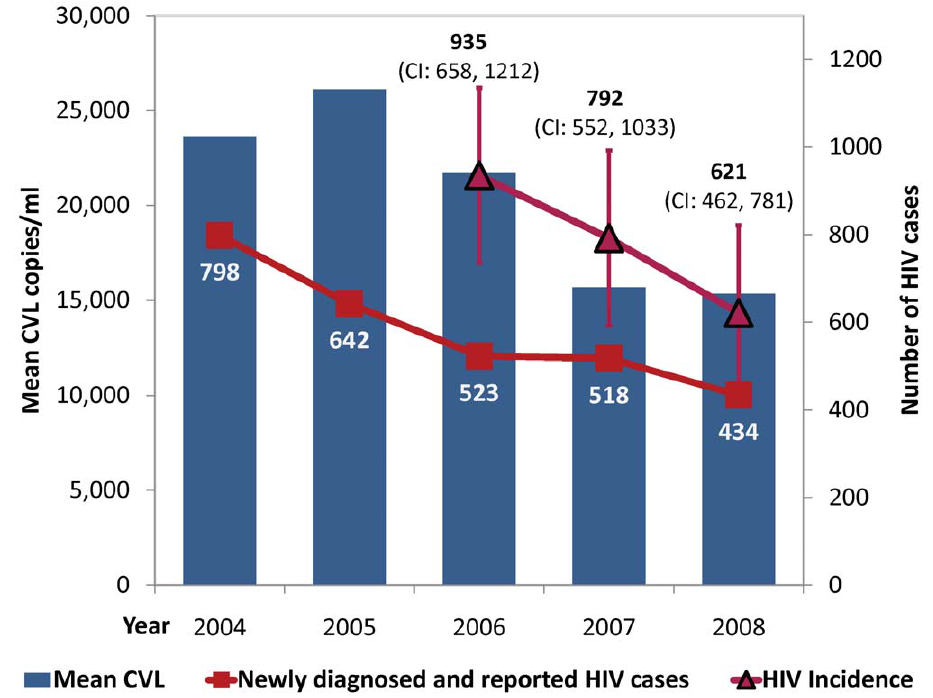
Figure 3. Mean CVL and New HIV Infections, 2004–2008. There was a statistically significant decline in annual measures of mean CVL from 2004–2008 (p=0.037). Newly diagnosed cases of HIV (shown in red with { ) decreased in San Francisco from 798 (2004) to 434 (2008) (p , 0.005). The point estimates of HIV incidence (shown in dark red with n ) using the CDC methods also declined from 935 [95% CI 658–1212] in 2006, to 792 [552– 1033] in 2007 and 621 [462–781] in 2008, although the change was not statistically significant (trend p=0.29). The reductions in annual measures of mean CVL were significantly associated with decreases in newly diagnosed and reported HIV cases from 2004–2008 (p=0.003). Longitudinal reductions in estimated HIV incidence were consistent with the trends in mean and total CVL, but the association in the meta-regression was not statistically significant (p . 0.3).